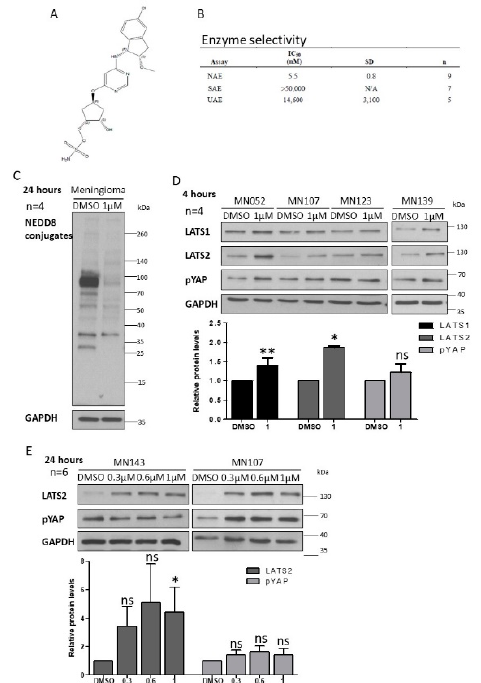
Figure 2. Inhibition of CRL4-DCAF1 neddylation by MLN3651. ( A ) MLN3651 chemical structure; ( B ) The table shows the neddylation activating enzyme (NAE) IC 50 values, determined using the Ubc12-NEDD8 Homogeneous Time Resolved Fluorescence (HTRF) thioester assay, and the IC